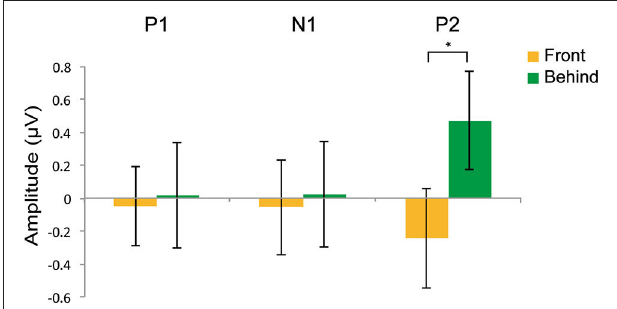
FIGURE 5 | Effects on repetition suppression in the EEG study . The epoch of P1was 90–145 ms; the epoch of N1 was 145–200 ms; the epoch of P2 was 200–285 ms. The error bars represent the standard error of mean. * P <